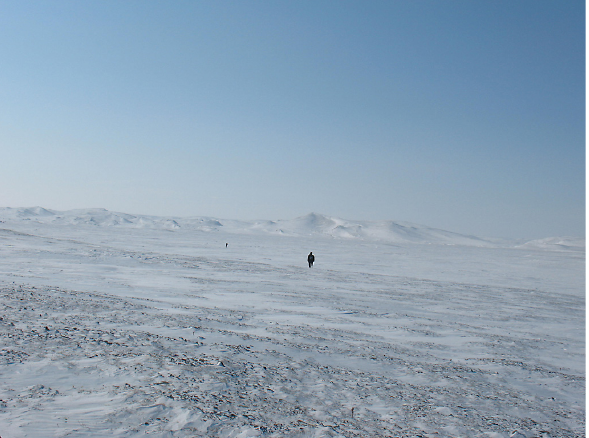
Fig. 13. A photo of the Tiksi-South sampling area, in eastern Rus- sia, in early